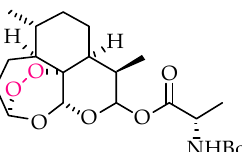
Figure 4. Structural representation of the antitoxoplasmic artemisinin derivative A2, studied by Deng’s group and selected as a lead for further development.